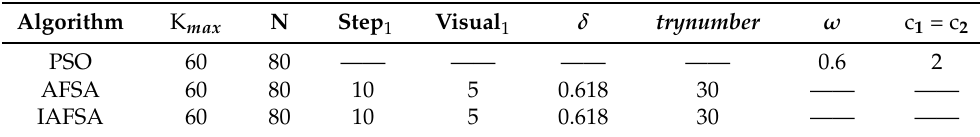
Table 4. Parameter settings of each algorithm for